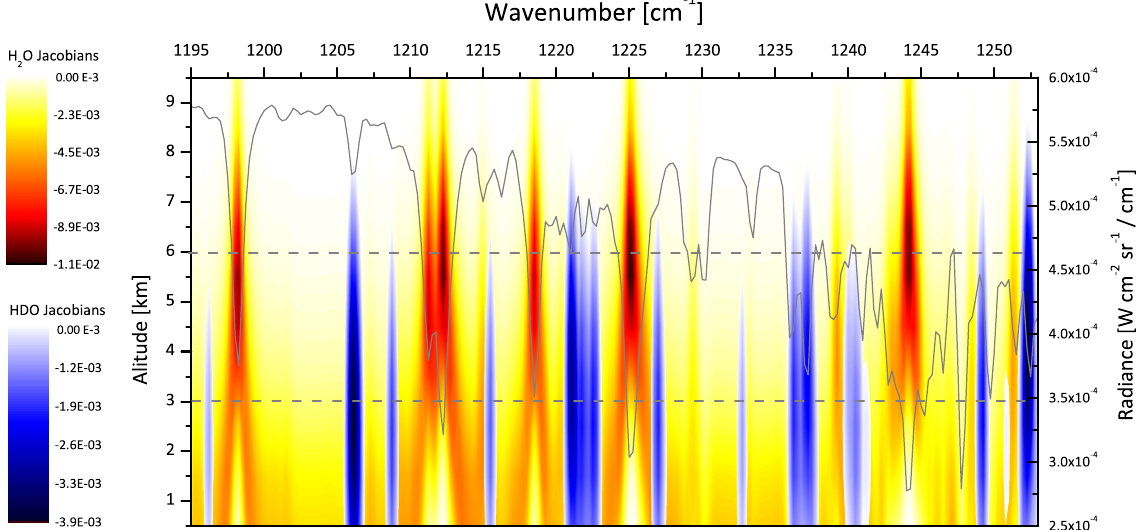
Fig. 3. Jacobians of H 2 O (yellow to dark red) and HDO (light blue to dark blue) as function of altitude and wavenumber. The smallest derivatives values indicate the maximum sensitivities. The gray dashed lines indicate the altitude of maximum sensitivity for both.